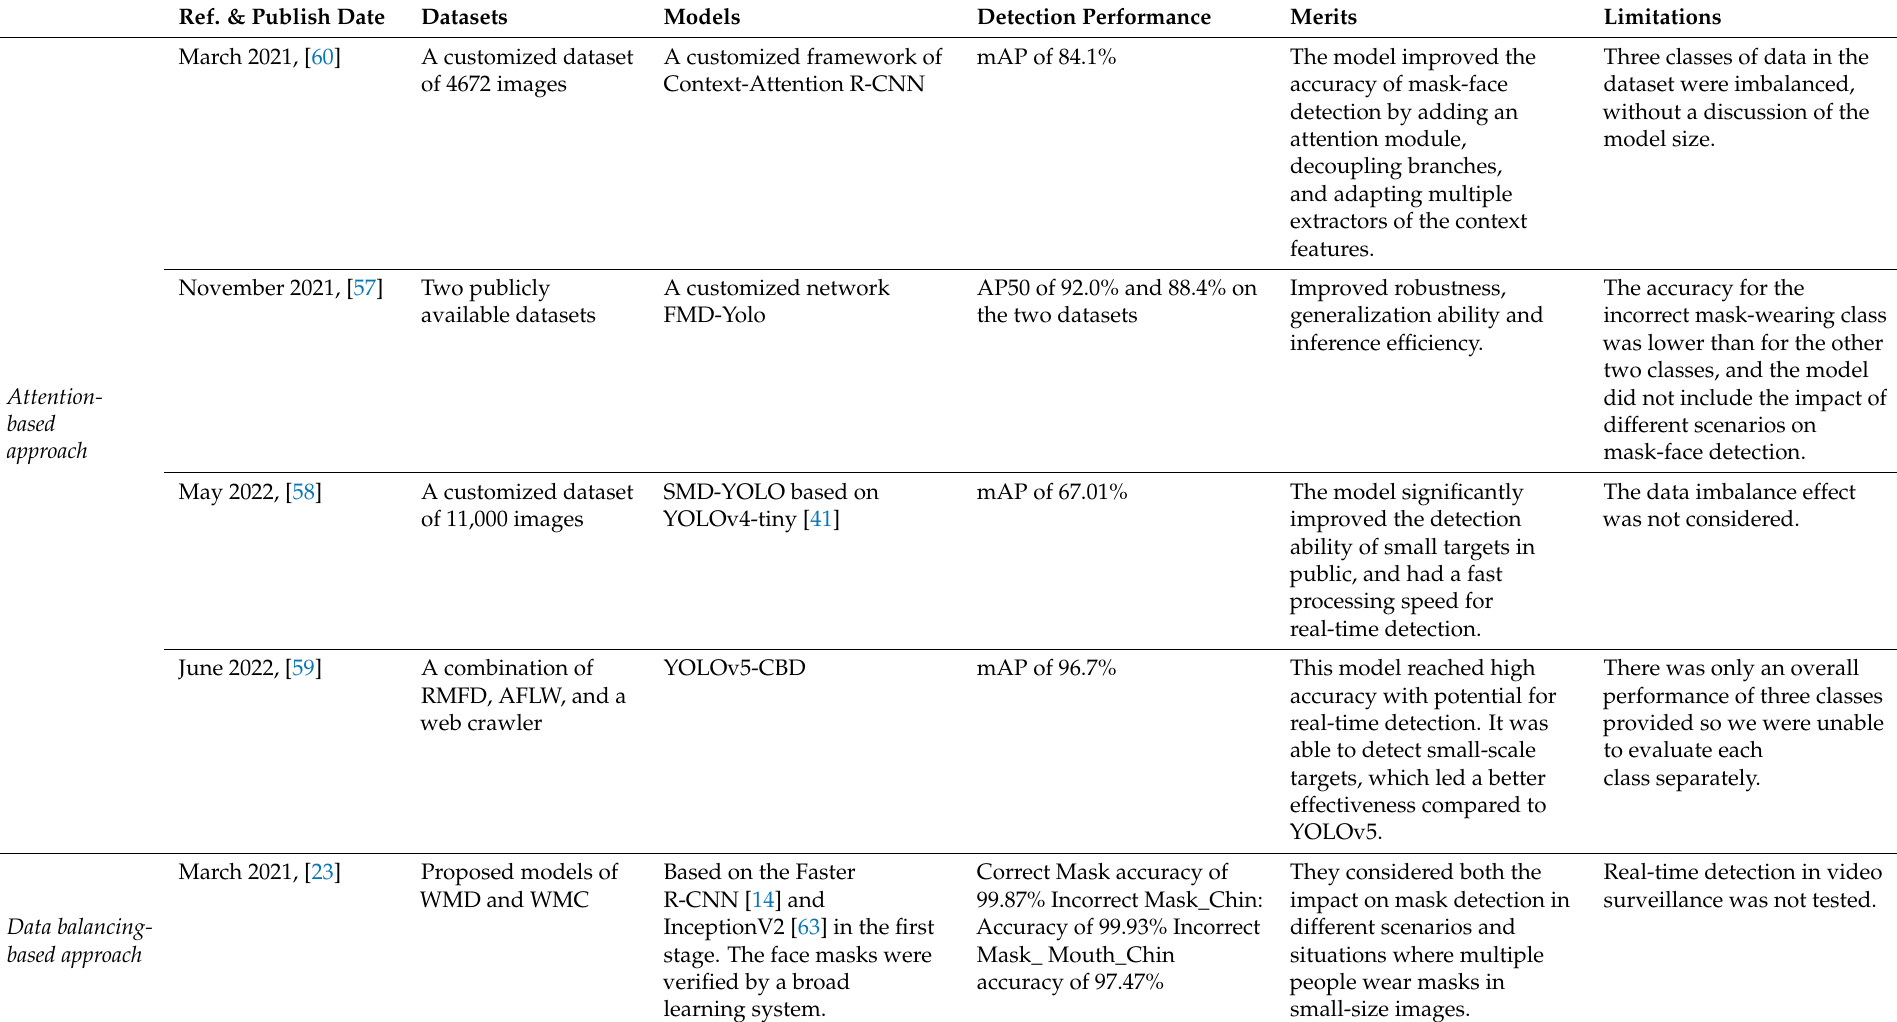
Table 3. Summary of three-class mask-face detection